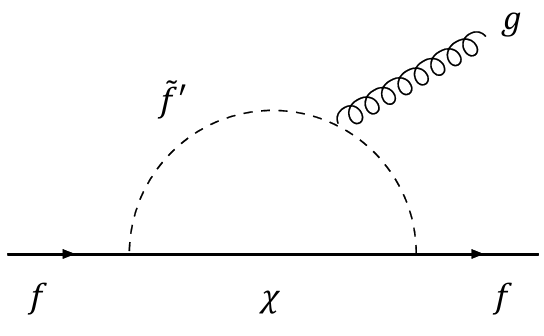
Figure 8 . The one-loop contribution to the CEDM of a fermion f